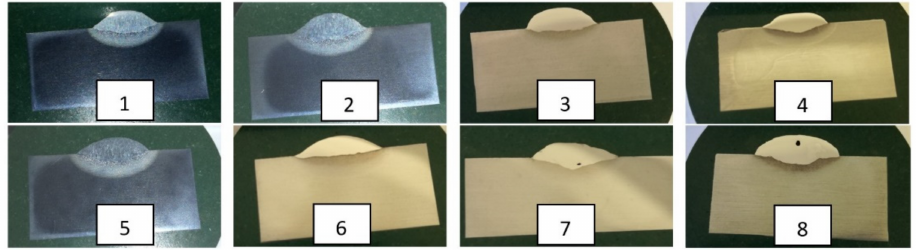
Figure 1. Macro cross-sections of analyzed single-bead surface welds (1, 2, 3, 4, 5, 6, 7, 8 single bead steel welds of eight different alloy-coated electrodes).